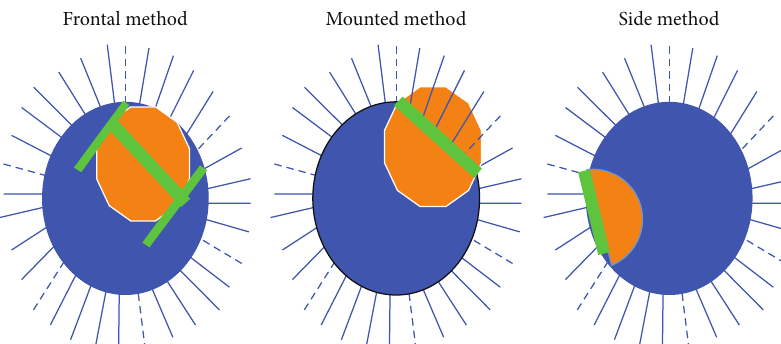
Figure 2: Three methods to measure polyp size using the calibrated hood. (1) “Frontal method”: the calibrated hood is placed directly over the top of the polyp, and the inner wall of the hood is brought into close contact with the side of the polyp. The diameter of the polyp is then calculated by envisioning horizontal lines extending from the hood’s calibrations. (2) “Mounted method”: the rim of the calibrated hood is placed over the diameter of the polyp. (3) “Side method” (sessile polyps only): the inner wall of the hood is brought into close contact with the diameter of the polyp base.